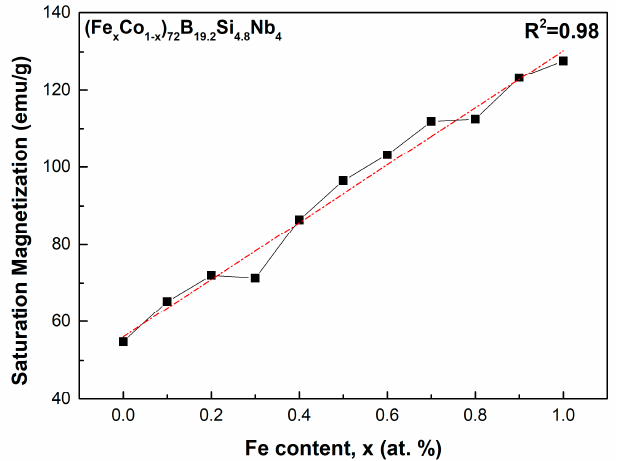
Figure 4. Saturation magnetization tendency of the (Fe x Co 1 − x ) 72 B 19.2 Si 4.8 Nb 4 (0 ≤ x ≤ 1, at 0.1 intervals) as-spun ribbons with linear regression analysis corresponding to R 2 value.